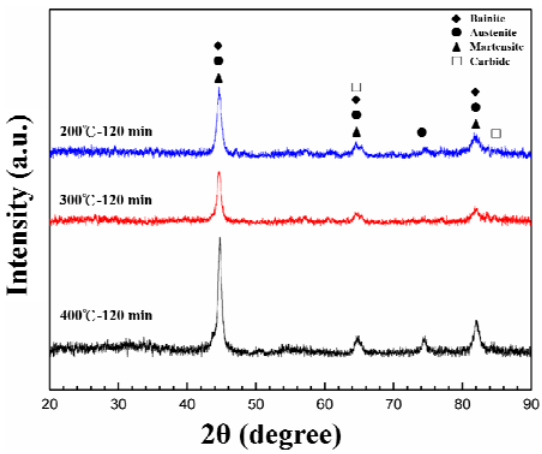
Figure 5. XRD of austempered specimens (1080 °C ‐ 30 min) with a salt ‐ bath time of 120 min and different salt ‐ bath temperatures.